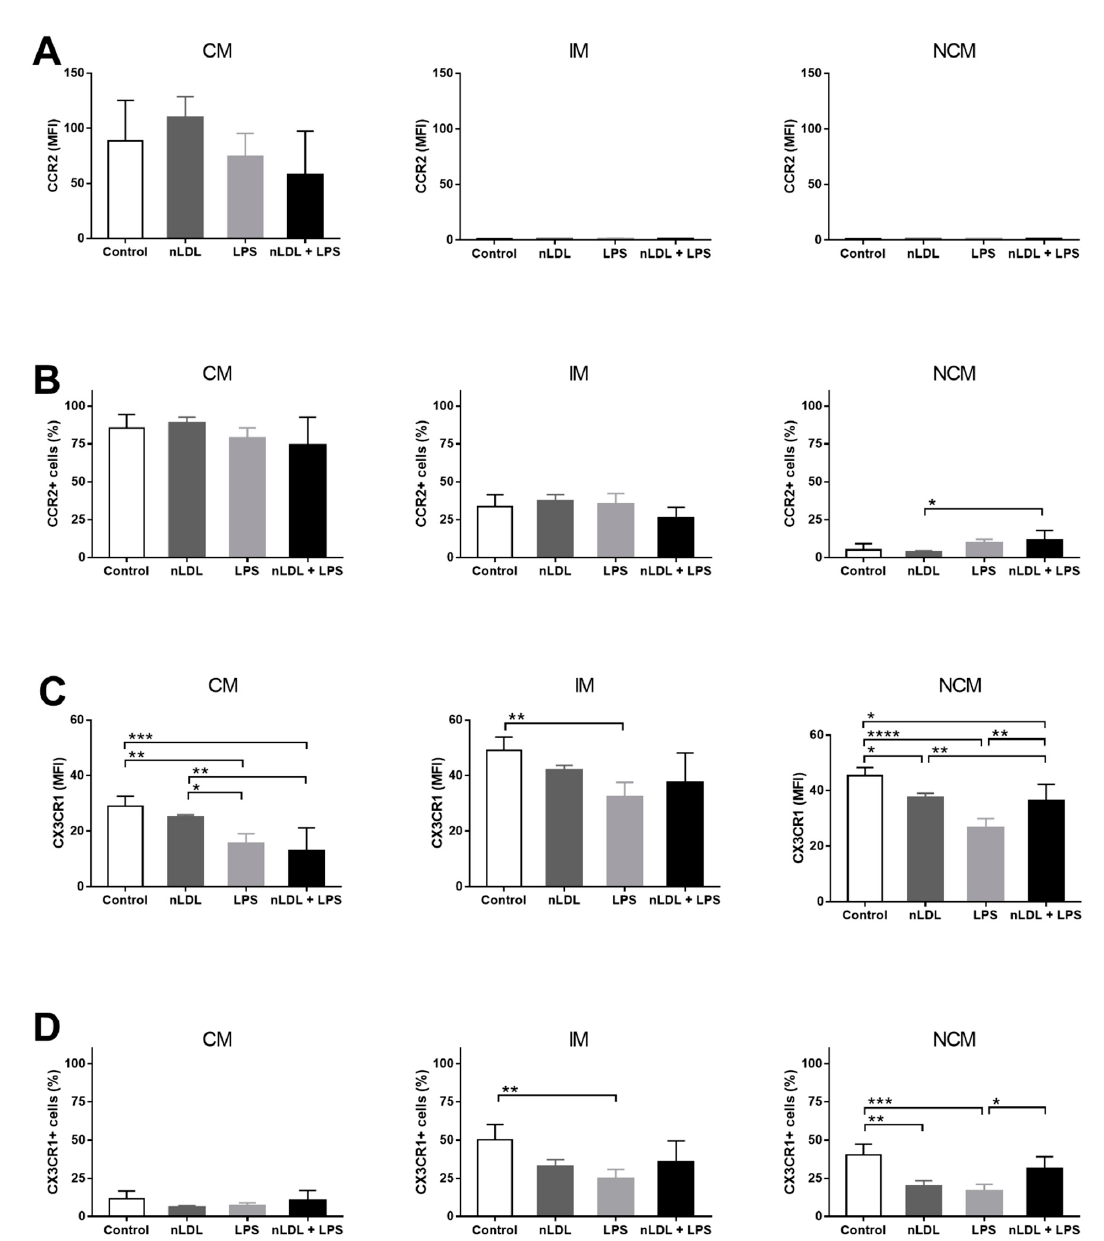
Figure 4. Effects of nLDL and LPS on CCR2 and CX3CR1 expression in human monocyte subpopulations. Although no significant differences were found, CCR2 expression was clearly higher in CMs than in IMs and NCMs ( A , left, middle, and right panels, respectively). The number of CCR2+ cells increased in the CM subset as compared to IM and NCM subpopulations ( B , left, middle, and right panels, respectively). In the NCM subset, LPS acted in synergy with nLDL to increase the amount of CCR2+ cells as compared to that found in cells only treated with nLDL ( B , right panel). Expression